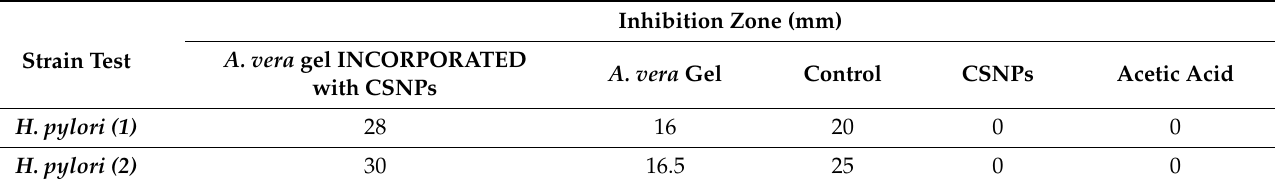
Table 2. Anti-Helicobacter pylori using A. vera gel and A. vera gel incorporated with CSNPs.